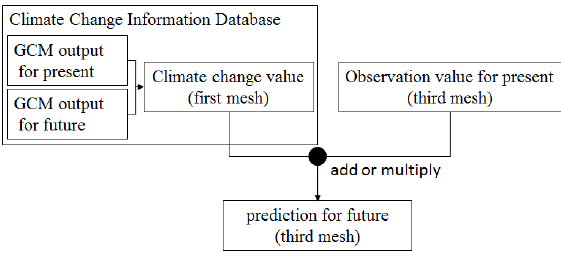
Figure 4. The climate change modification method based on observation value (Modified after Michihiro et al., 2012)